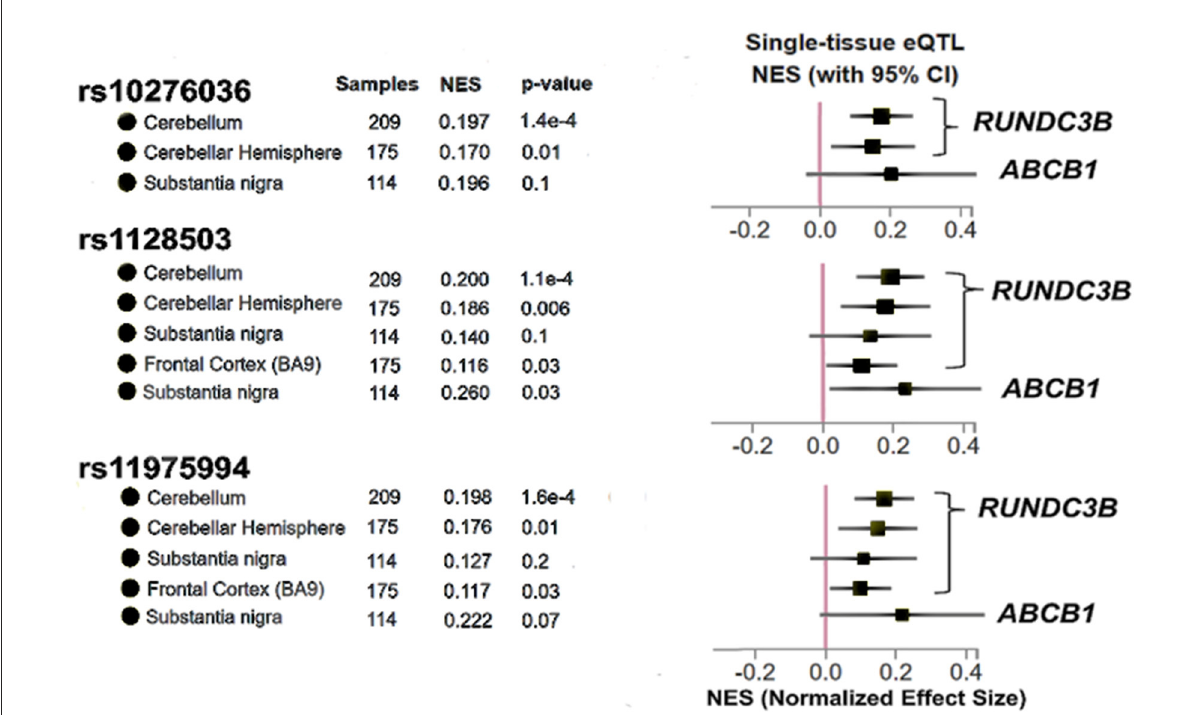
FIGURE3 Results adapted from the Genotype Tissue Expression database (GTex) for the three SNPs identified in this study (rs10276036, rs1128503, rs11975994). The x-axis represents Normalized Effect Size (NES) where an increase in NES represents a SNP increasing expression of a particular gene, while a decrease in NES would represent a SNP modulating gene expression by decreasing expression. P -values shown for each brain region for each SNP are used to determine if a SNP is an expression quantitative trait locus shown for the gene shown on the right of the figure. P < 0.05 was used to determine